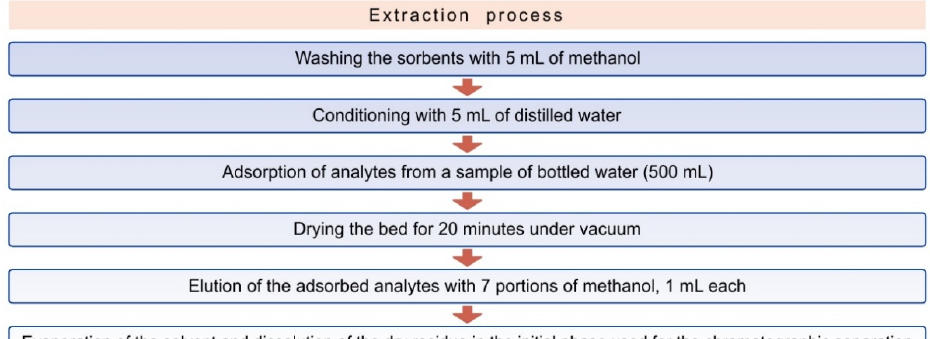
Figure 3. Steps of the SPE extraction process.